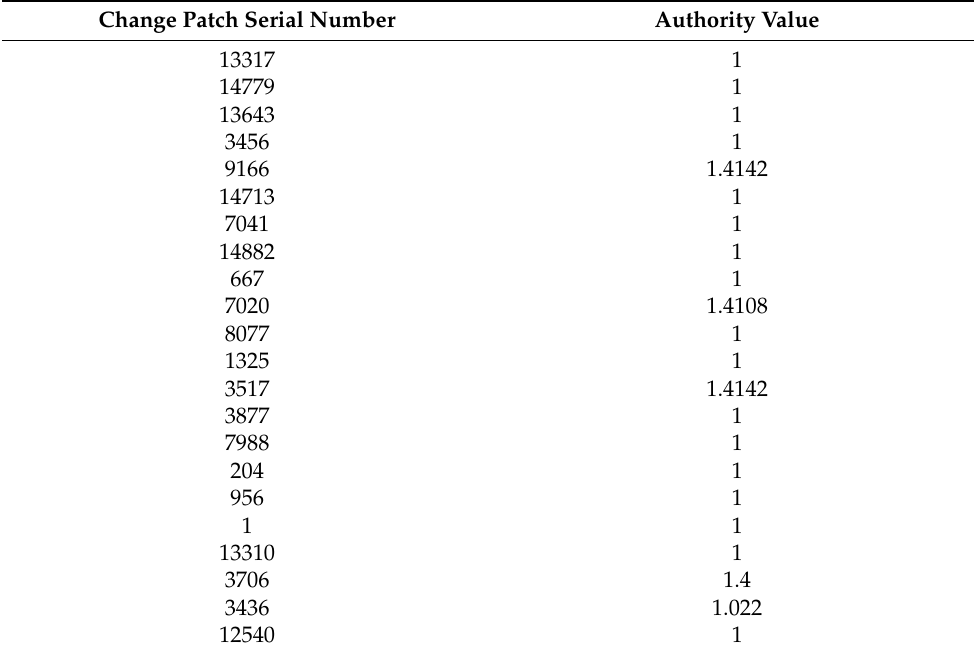
Table 9. An example of online crowdsourcing data computing results.